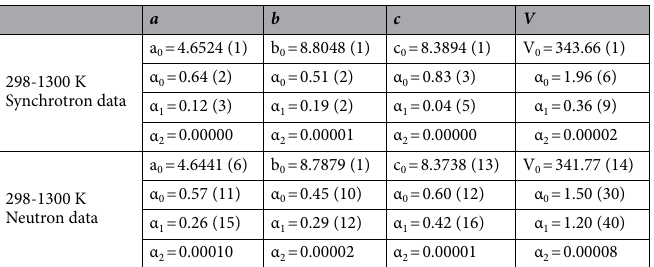
Table 3. Thermal expansion coefficient for all crystallographic values calculated from synchrotron and neutron diffraction data, respectively. Thermal expansion coefficients were calculated by EosFit7-GUI software 31